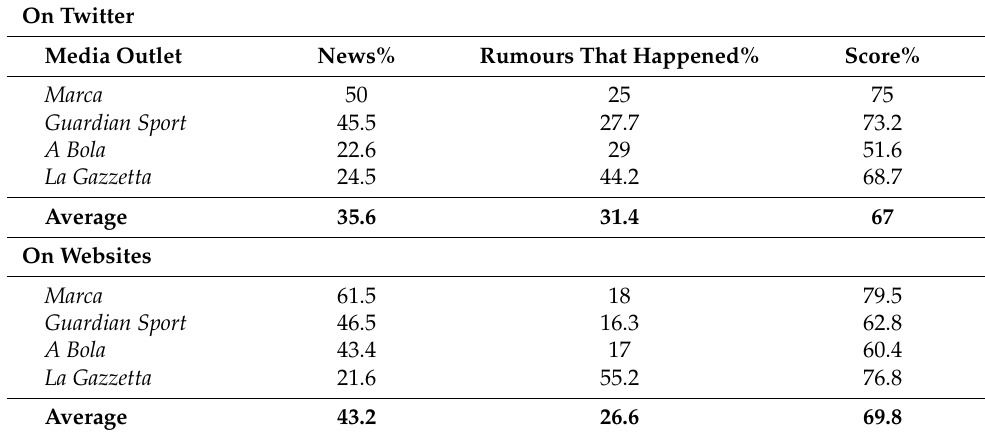
Table 4. The table shows the scores of accuracy obtained by each sports media